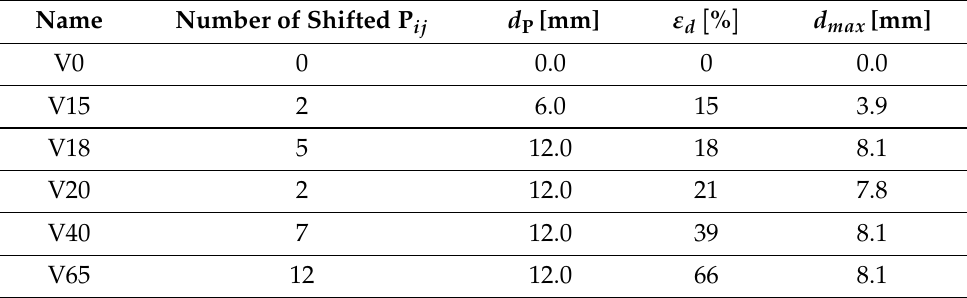
Table A1. Simulated data sets, the maximum distortions d max of which are generated by a shift d P of one ore more control points. The denotation of the data sets contains the percentage of distortion ε d [30].